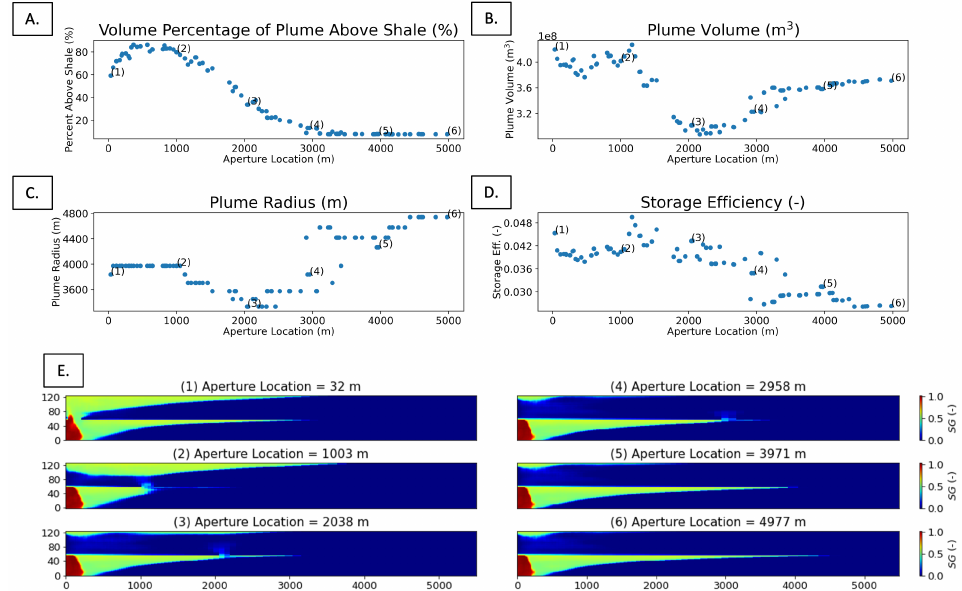
Figure 10. The impact of aperture location on plume migration. The first four ( A – D ) plots illustrate the relationship between four plume variables and the shale length. The bottom six plots ( E ) show the gas saturation map of six modeled cases (labeled in the above plots).